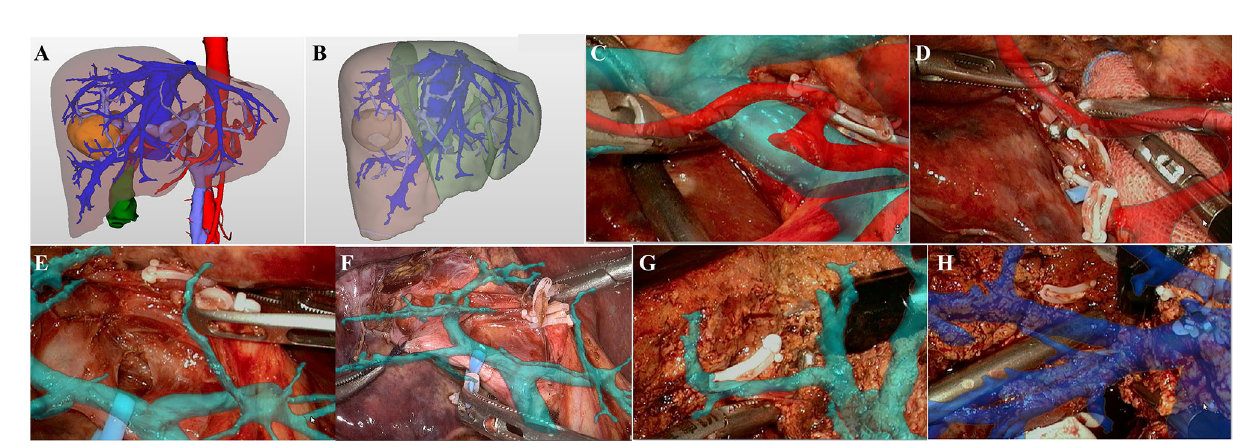
FIGURE 3 | LARN-assisted right posterior sectionectomy. (A) , the lesion was located in the right posterior sector from 3D visualization. (B) , the resected liver volume was calculated to be 340.12 ml (41.33%) based on simulated hepatectomy. (C) , intraoperative navigation of the main PV and hepatic artery. (D) , intraoperative navigation of the right hepatic artery. (E) , the right PV was suspended under the image navigation. (F, G) , the right posterior PV branch was dissected and severed with the assistance of LARN. (H) , intraoperative navigation of the hepatic veins in S6 and S7.